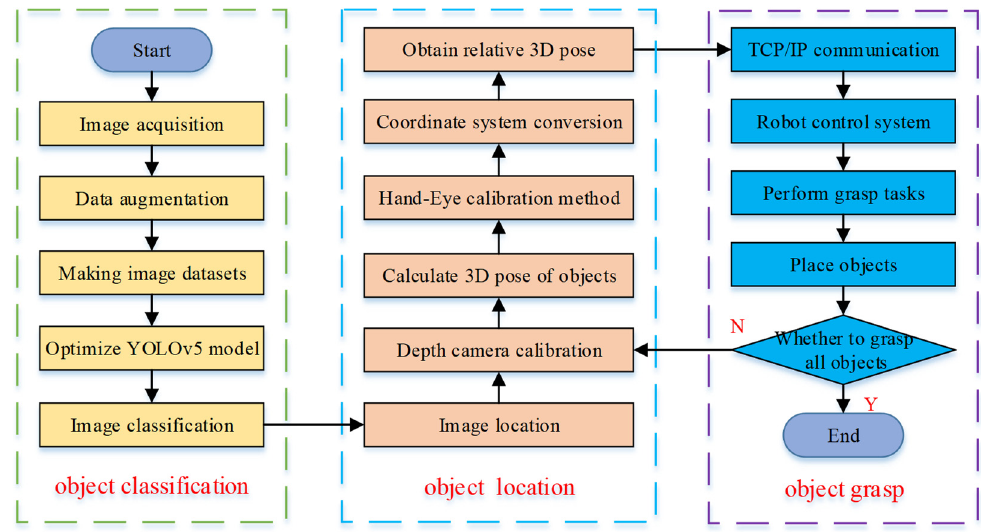
Figure 3. Flow chart of grasping robot object detection experiment .